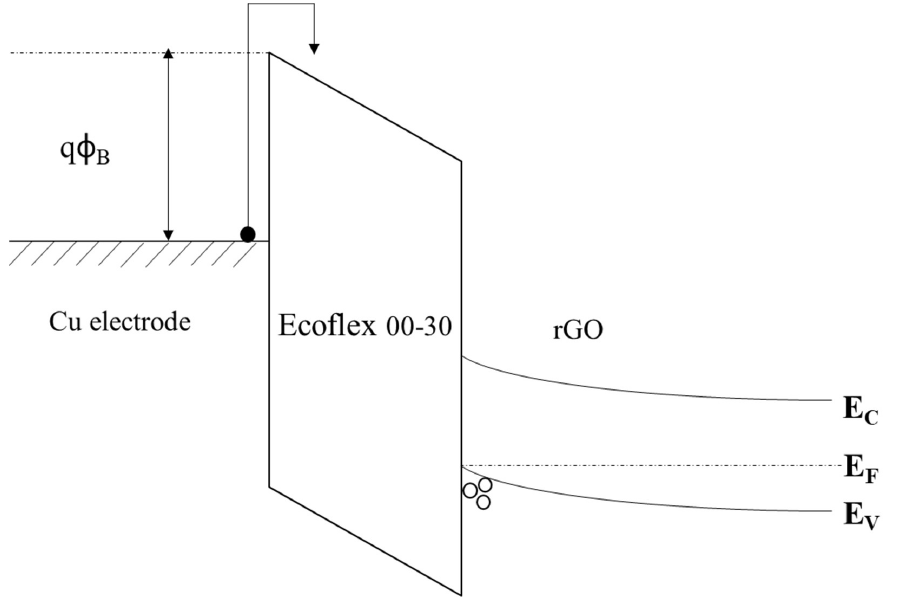
Figure 7. A band diagram showing the Schottky/thermionic emission in Region I.